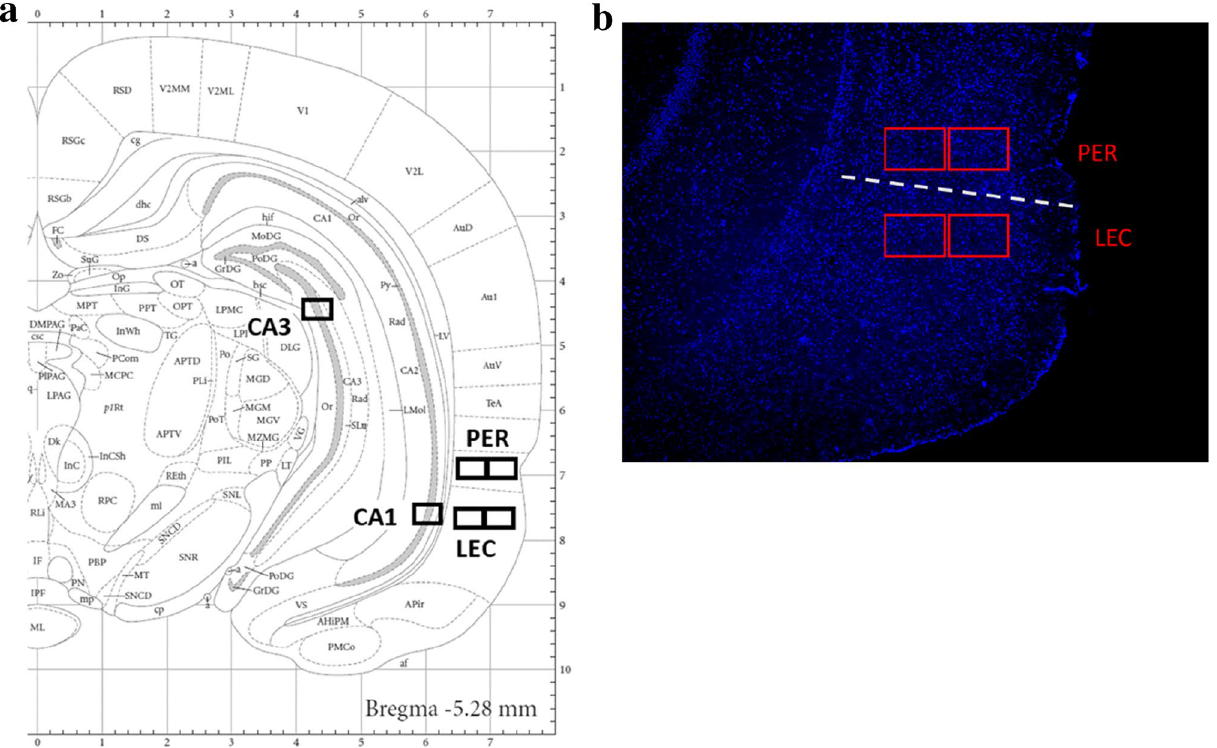
Figure 4. ( a ) Location of the imaging frames for the regions of interest. CA1 cornu ammonis field 1, CA3 cornu ammonis field 3, PER perirhinal cortex, LEC lateral entorhinal cortex. ( b ) Example of a DAPI counterstained rat coronal section with PER and LEC imaging frames (red) and the PER/LEC border (dashed line). Calbindin staining was used to define the border between the PER and the LEC in prior experiments. LEC imaging frames were one frame distant from PER frames to ensure that LEC activity was